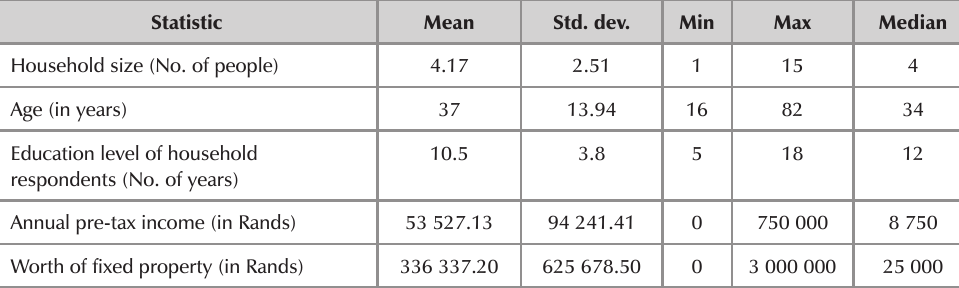
Socio-economic profile of household respondents – Underberg